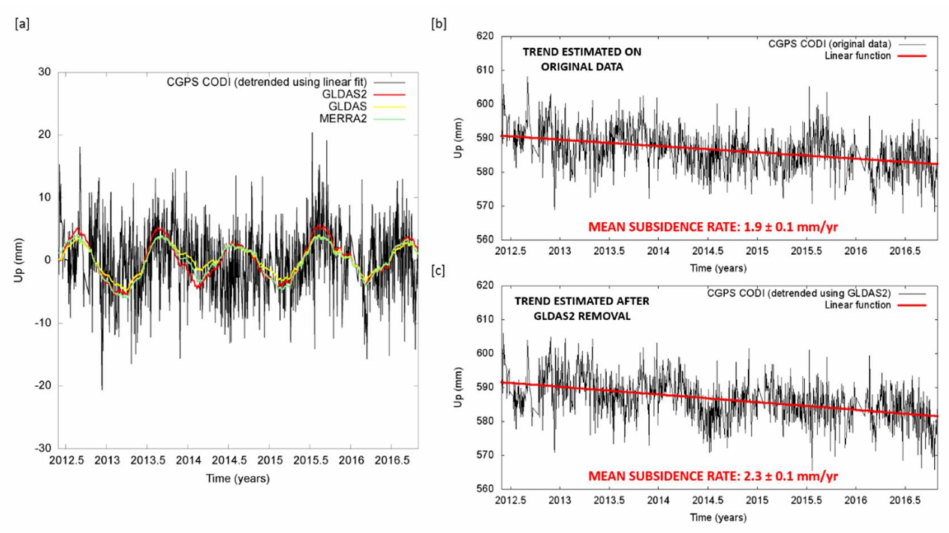
Figure 10. Vertical movements (Up) provided by global hydrological loading models (MERRA2, GLDAS, and GLDAS2) and CODI CGPS geodetic time series. ( a ) Match between residual geodetic data and computed displacement from the models; ( b ) linear fit of the original geodetic data; ( c ) linear fit of the geodetic data residuals from GLDAS2 modeling